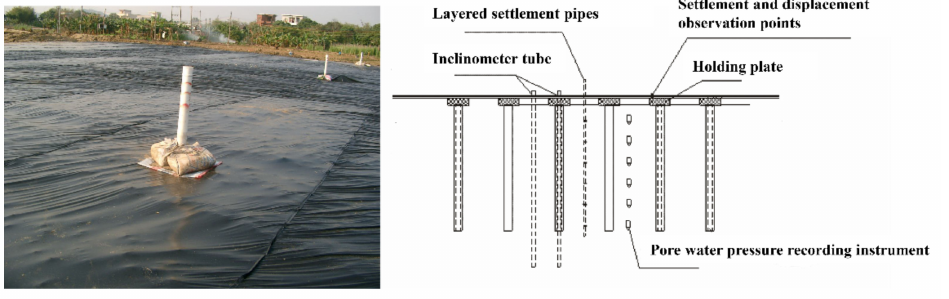
Figure 6. Layout of the monitoring instruments at the site. Three settlement measurement points were selected in the field, as indicated in Table 4. Calculations were carried out with the model proposed in this paper. Table 4. Measured values of the settlement points for the expressway. Measured R Settlement Points